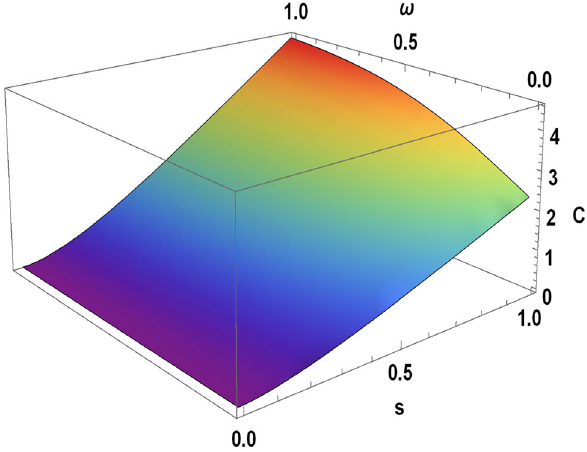
Fig. 1 The Gaussian quantum coherence between Alice and Bob for the different ω and s . The GHS dilaton charge parameter and mass parameter are fixed as D / M = 0 .